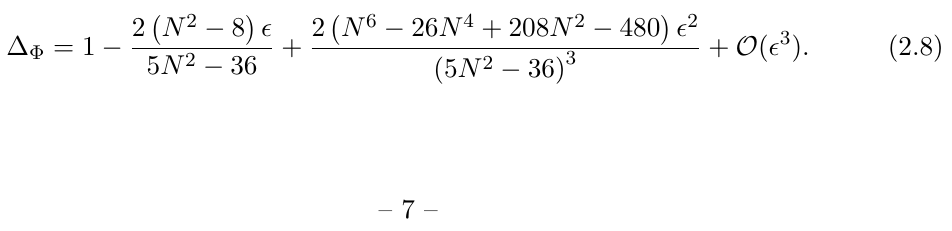
Figure 5 . SU( N ) invariant N = 1 SCFT bootstrap. Bound on ∆ i symmetry group size N . The red curve being the two loop prediction of ∆ R-charge singlet scalar operator, whose scaling dimension was shown to be 1.9098(20), using N =2 bootstrap in